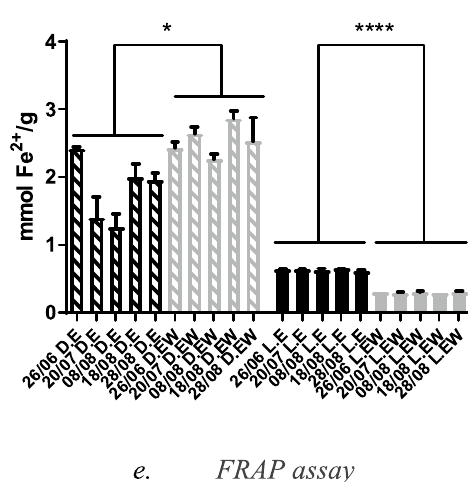
Figure 1. Polyphenol (a) and flavonoid content (b) and antioxidant capacity in DPPH/EPR test (c) , in ORAC assay (d) and in FRAP assay (e) in ethanol (E, black) and ethanol–water (EW, gray) extracts prepared from air- dried (D, stripes) and lyophilized (L, filled) flowers of H. perforatum L. for different harvest time (26.06, 20.07, 08.08, 18.08 and 28.08). The values are means with standard deviation). In the figure mean values with standard deviation are denoted. Additionally, to encode the statistical significance asterisks are used: (****)—p < 0.0001; (***)—p < 0.001; (**)—p < 0.01; (*)—p < 0.05; (ns)—p